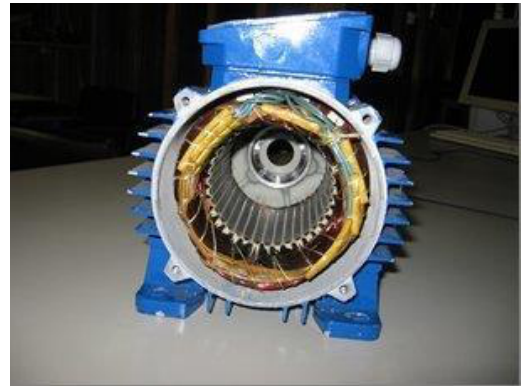
Figure 12. The stator of the Sh 71-4B motor.